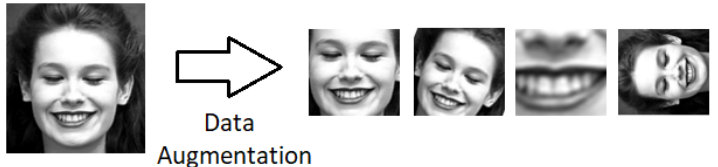
Figure 11. DA results on a face from the CK+ database.